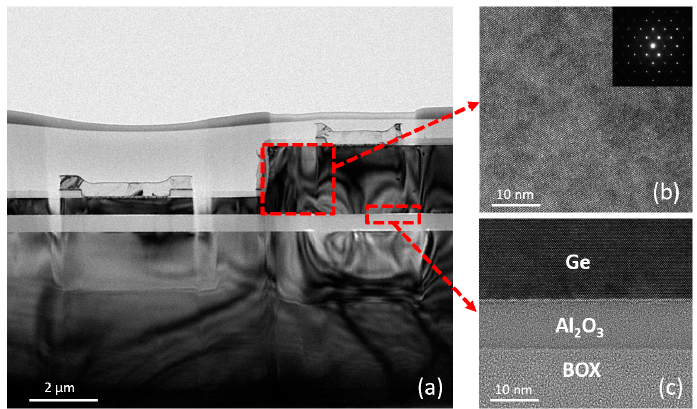
Figure 2. ( a ) Cross-sectional transmission electron microscopy (TEM) image of GOI p-i-n photo- detectors. ( b ) High-resolution TEM image with its selected area diffraction (SAD) image (the inset) in the Ge layer, and ( c ) the Ge/Al 2 O 3 /SiO 2 interface.